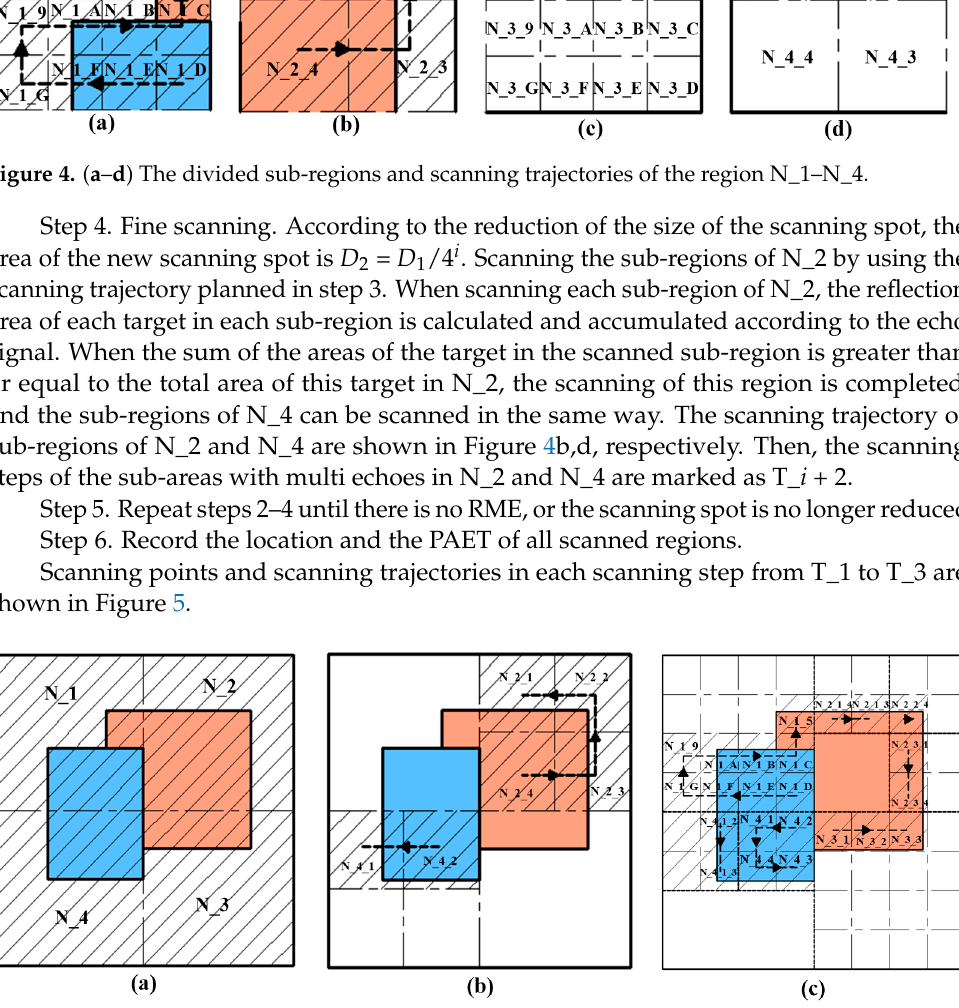
Figure 5. ( a – c ) Scanned sub-regions and scanning trajectories in the scanning step from T_1 to T_3.